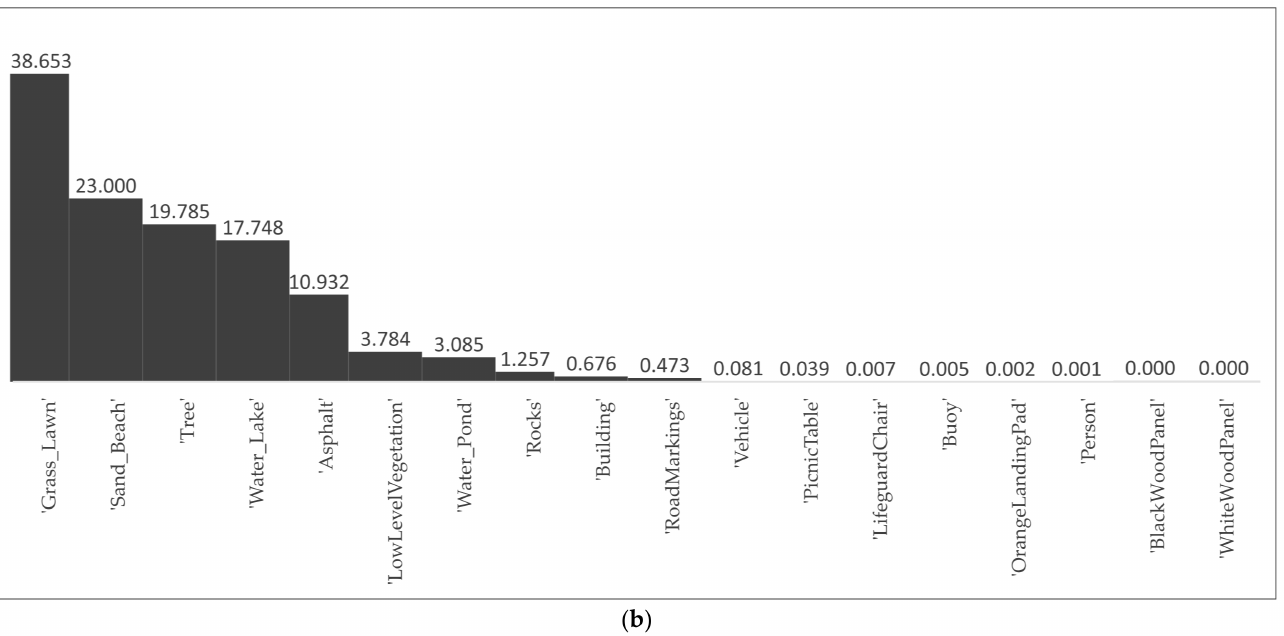
Figure 1. Percentage of each class in RIT-18: ( a ) training image (%), ( b ) test image (%). The LC-Net is defined as a 1 × 1 group convolution layer with 2 bands per group at the initial stage of the networks. This setup will compress two adjacent input bands in sequence without any overlap, as shown in Figure 2. More specifically, each band was multiplied by a weight, and, after that, two adjacent bands (i.e., bands 1 and 2, bands 3 and 4, and bands 5 and 6 for the RIT-18 dataset) were added together to form three new bands. The weights applied to the bands were randomly initialized and iteratively updated during the training.